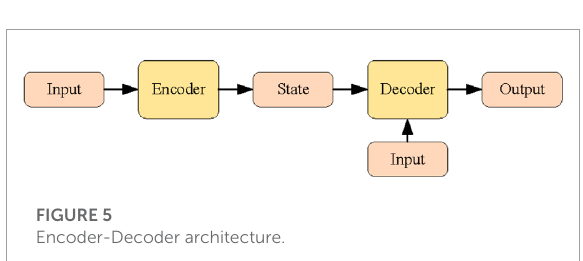
FIGURE 5 Encoder-Decoder